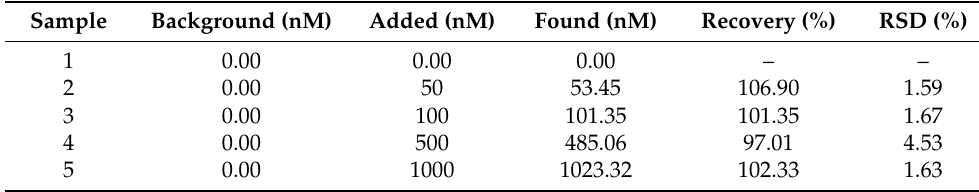
Table 2. Detection of AAs in spiked milk